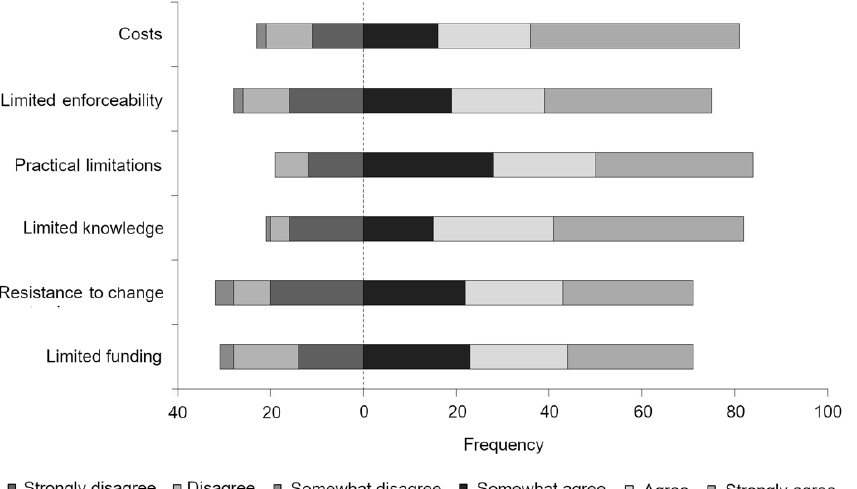
Figure 7. Veterinary perceptions towards barriers to welfare-related change, where the dashed line represents the point between disagreement and agreement based on responses to a 6-point Likert-type